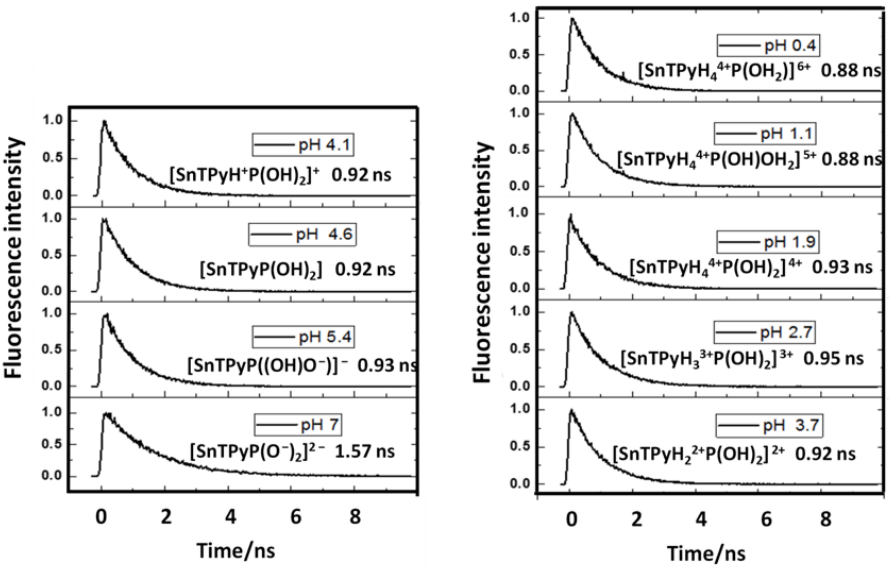
Figure 5. Fluorescence decay profile of each excited SnTPyP in different protolytic form on the axial ligands and peripheral pyridyl groups. ligands and peripheral pyridyl